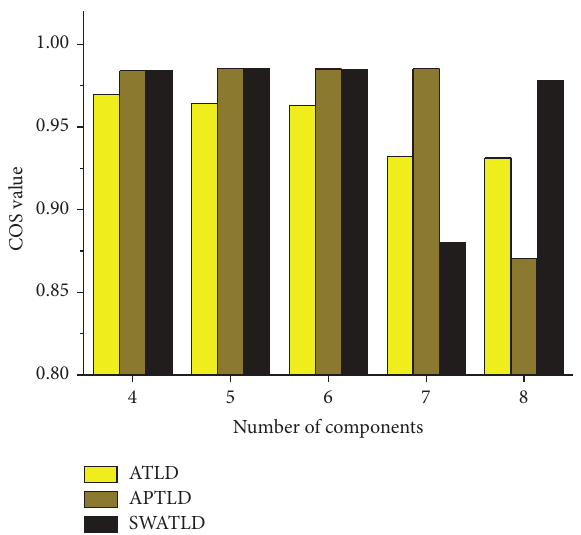
Figure 6: Comparison of mean recovery of quantization corre- sponding to three different algorithms and a varying number of